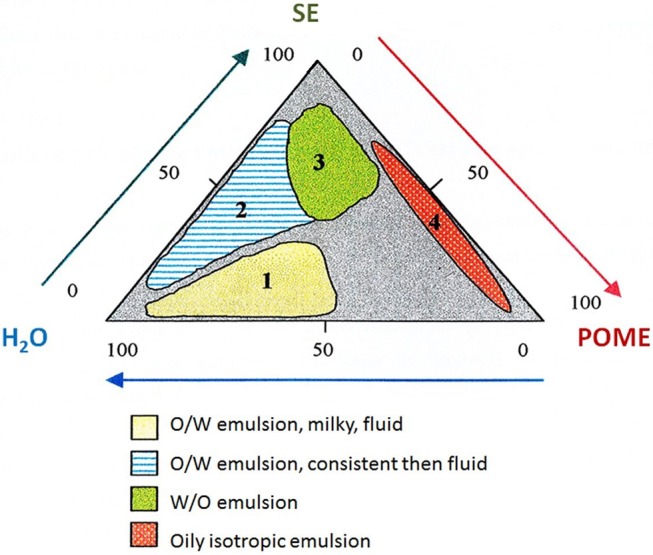
Pseudo-ternary phase diagram for POME/H2O/SE mixture. POME: palm oil methyl ester; SE: sucrose ester. Adapted from Claverie (1998).